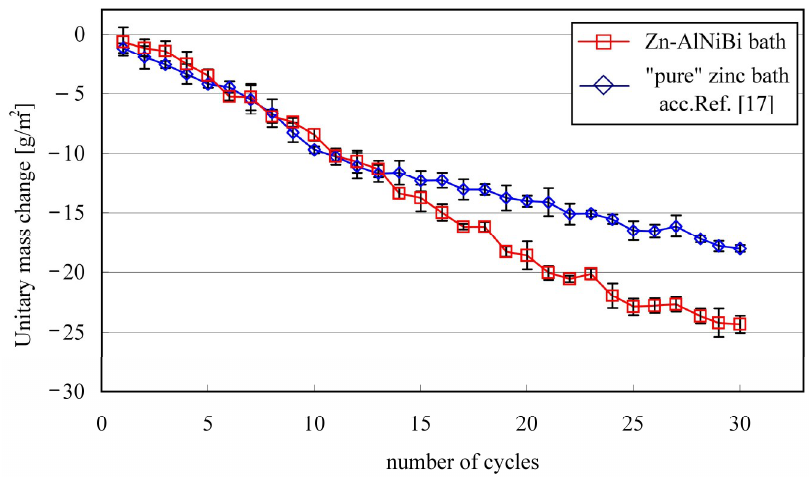
Figure 9. Unitary changes in the mass of “pure” zinc and Zn-AlNiBi coatings during the sulfur dioxide test in a humid atmosphere.